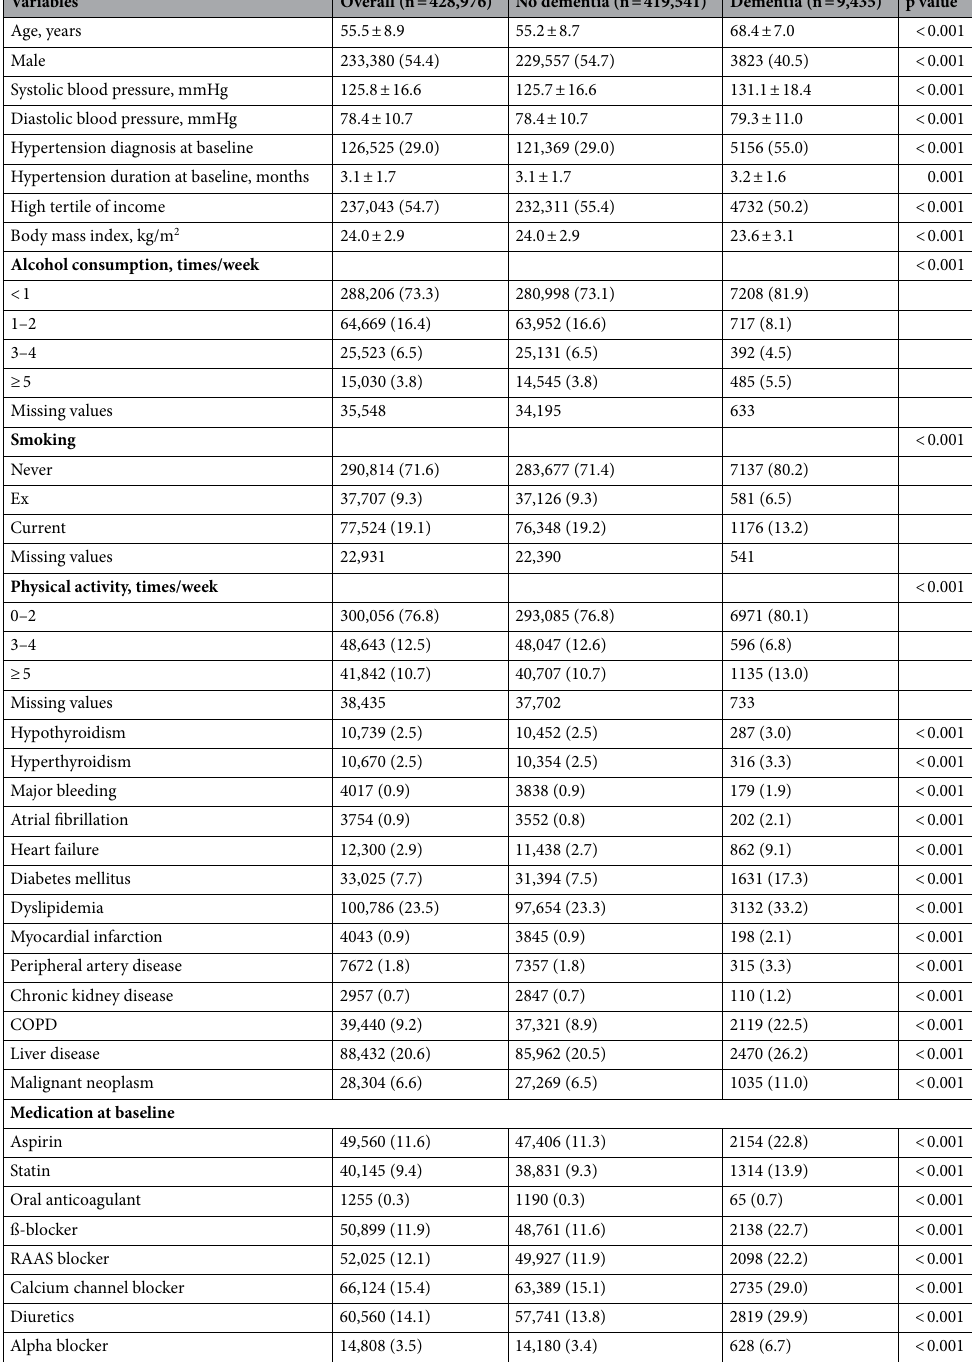
Table 1. Baseline characteristics of patients based on dementia status at the end of follow-up. Values are presented as mean ± standard deviation or n (%). COPD chronic obstructive pulmonary disease, RAAS renin– angiotensin–aldosterone